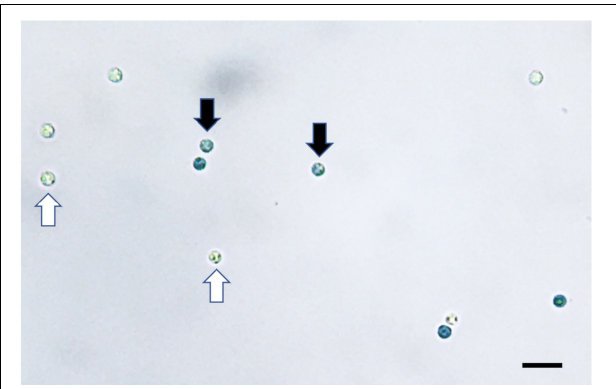
FIGURE 2 | Plasmodiophora brassicae resting spores stained with Evans blue visualized under the optical microscope. Black arrows indicate dead spores (blue), white arrows indicate viable spores (colorless), bar = 10 µ